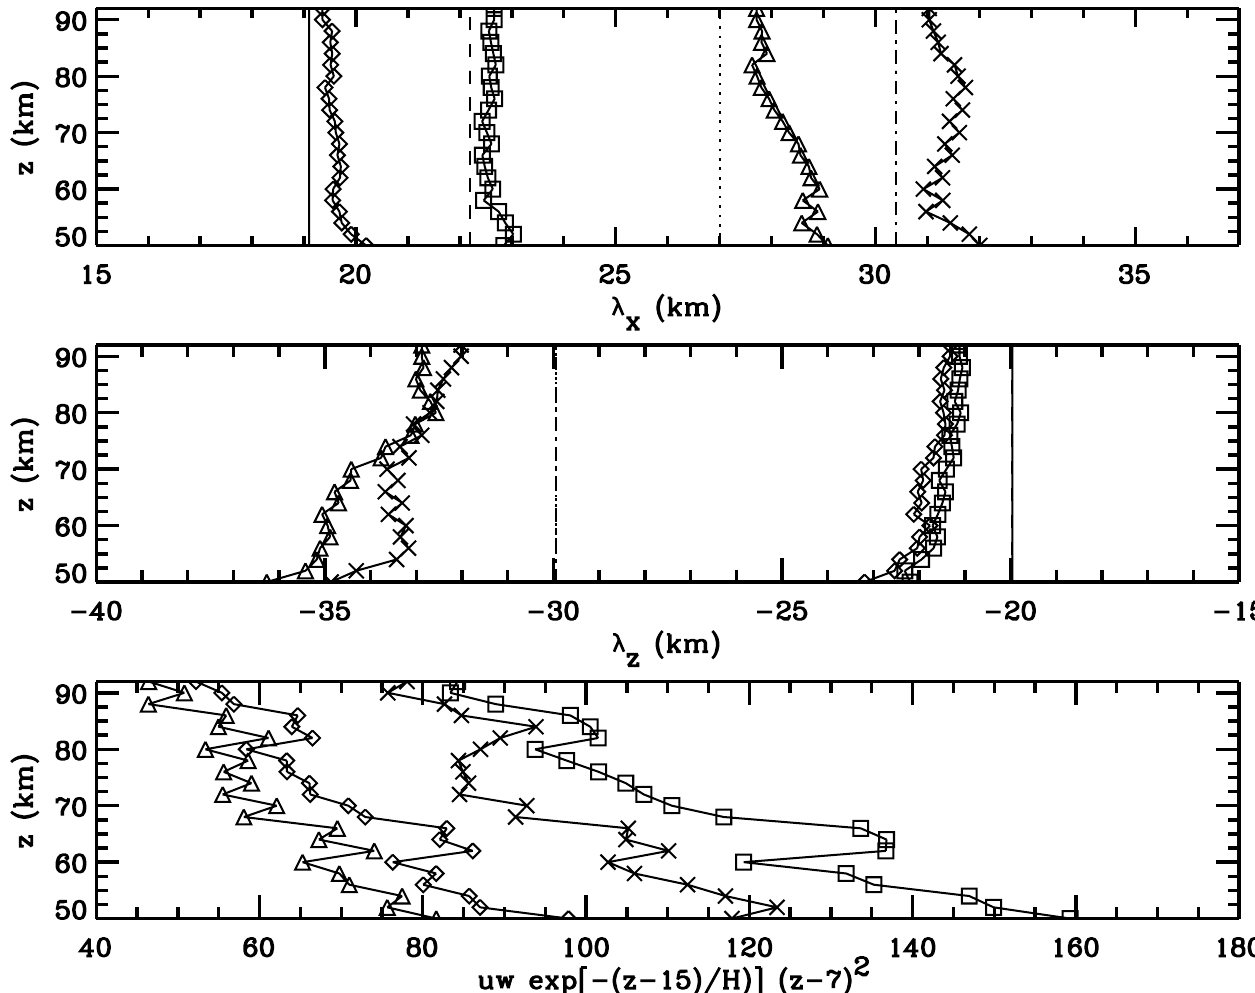
Fig. 14. (a) Solid, dot, dash, and dash-dot lines show λ x from ray tracing each individual GW from left to right in Table 2, respectively. Diamonds, triangles, squares, and x’s show the average values of λ x in the ray trace bins closest to the individual GWs from left to right in Table 2, respectively. (b) Same as in (a), but for λ z . (c) Average momentum fluxes times (z − z 0 ) 2 exp ( − (z − z trop )/ H ) for the bins closest to the individual GWs. Symbols are the same as in (a).